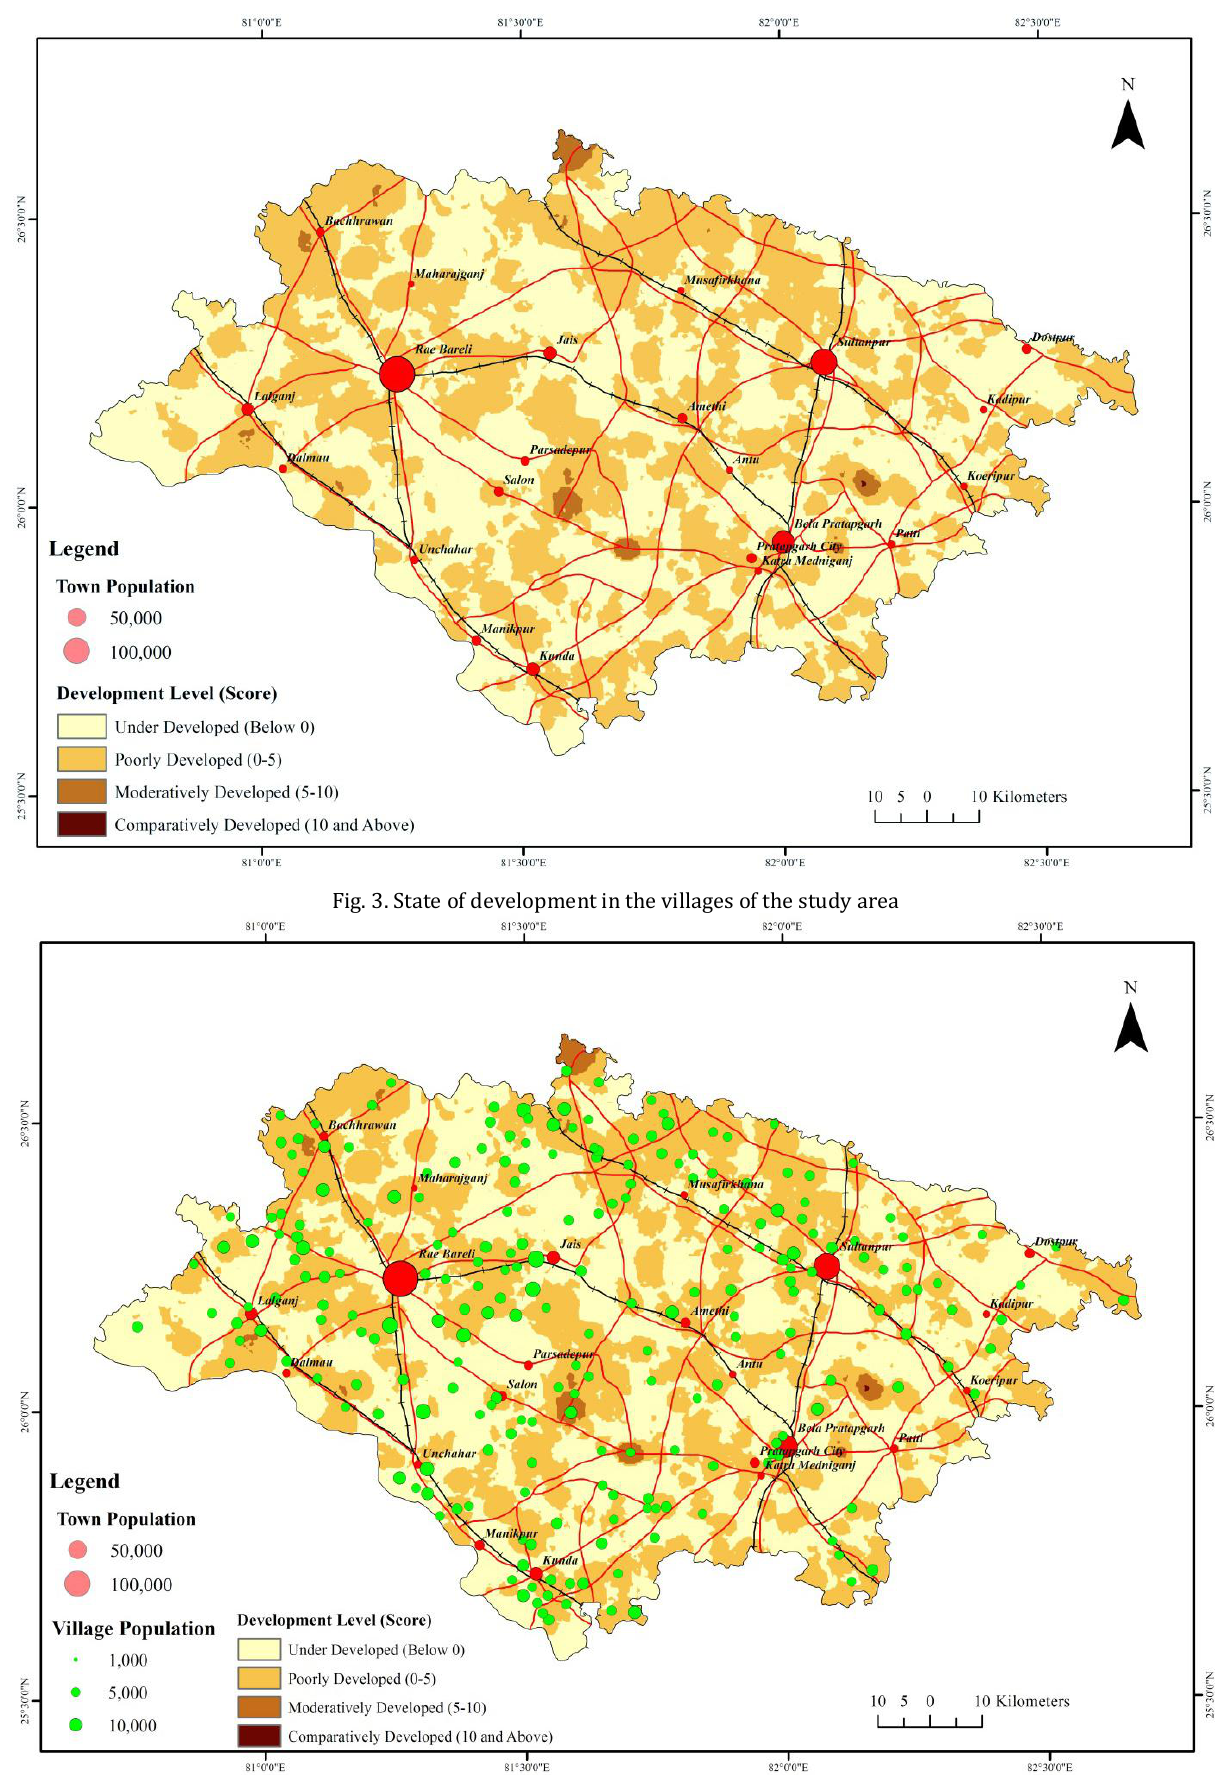
Fig. 4. Rurban villages and regional